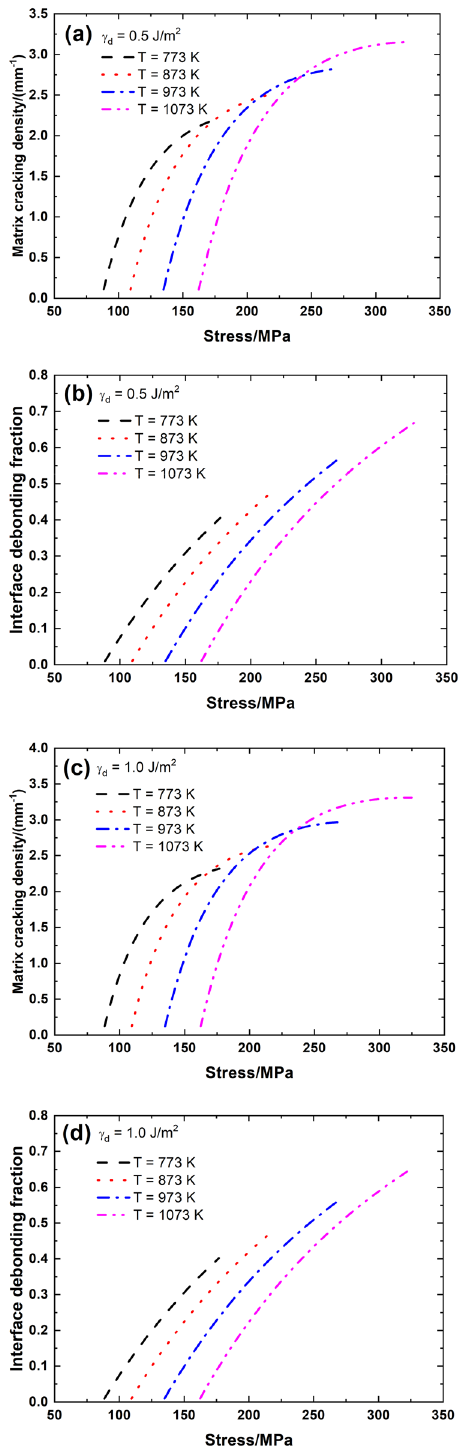
Figure 2: ( a ) The matrix multicracking density versus applied stress curves when γ d = 0.5 J/m 2 ; ( b ) the interface debonding fraction versus applied stress curves when γ d = 0.5 J/m 2 ; ( c ) the matrix multicracking density versus applied stress curves when γ d = 1.0 J/m 2 ; and ( d ) the interface debonding fraction versus applied stress curves when γ d = 1.0 J/m 2 of C/SiC composites at elevated temperatures of T = 773, 873, 973, and 1,073